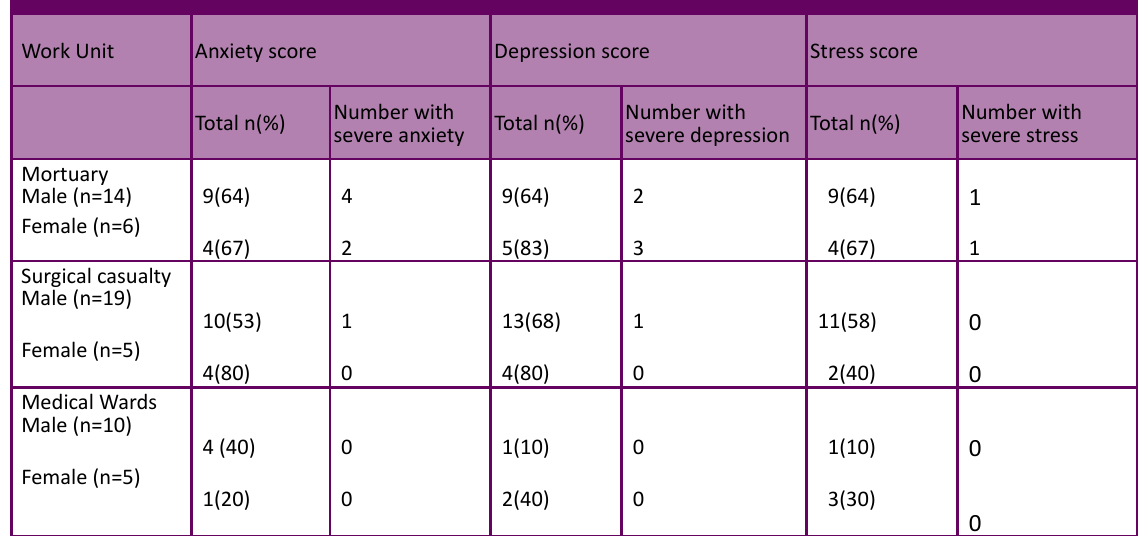
Table 2. Severity of stress, anxiety and depression Work